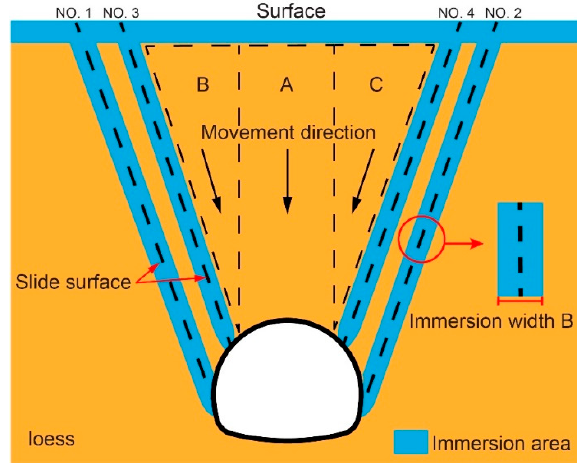
Figure 5. Schematic diagram of slide surface immersion.